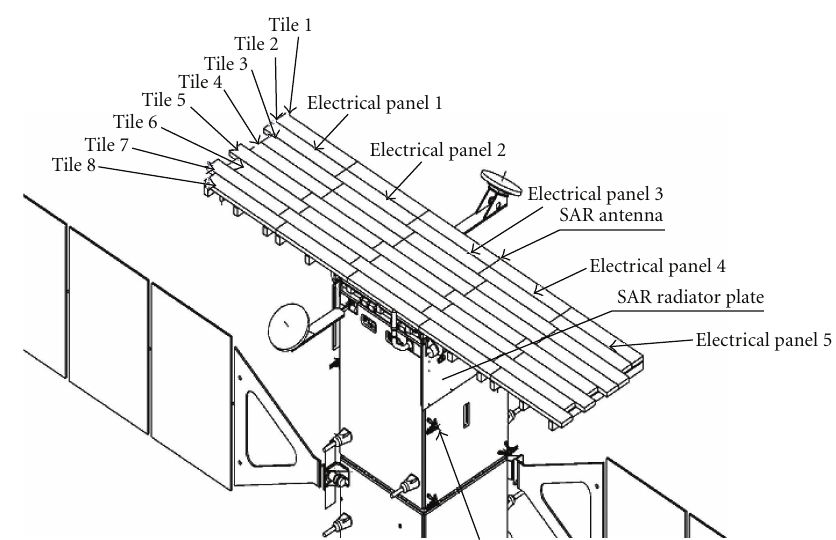
Figure 3: Antenna organization in